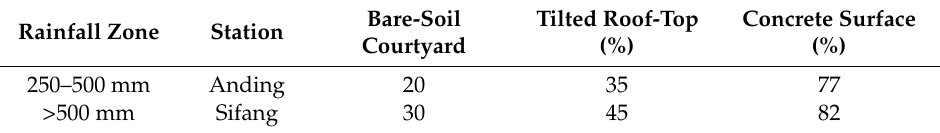
Table 6. Rainwater collection efficiencies for different surface materials and rainfall